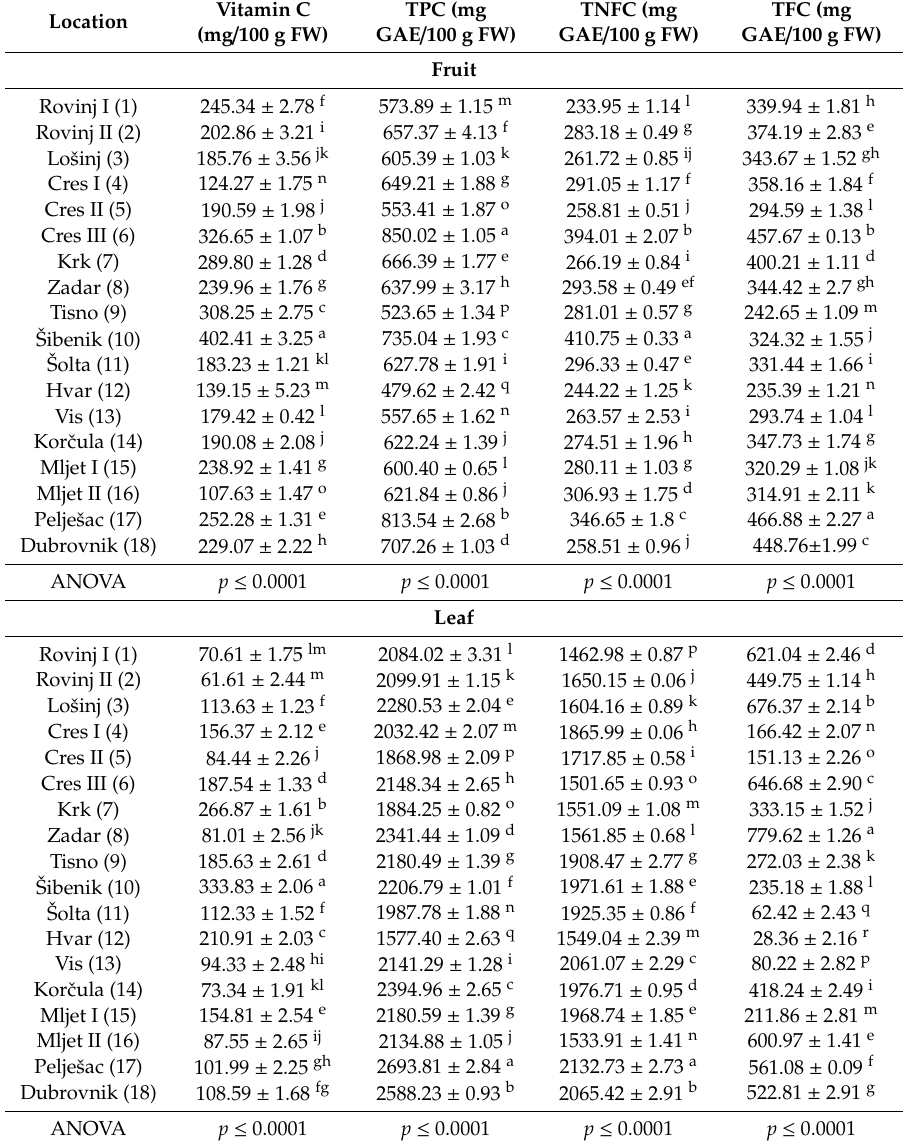
Table 2. Bioactive compounds content of strawberry tree fruits and leaves from di ff erent